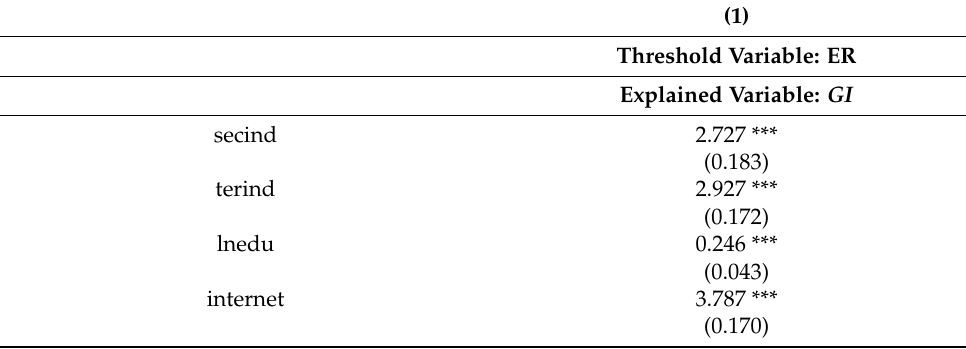
Table 8. Threshold model regression